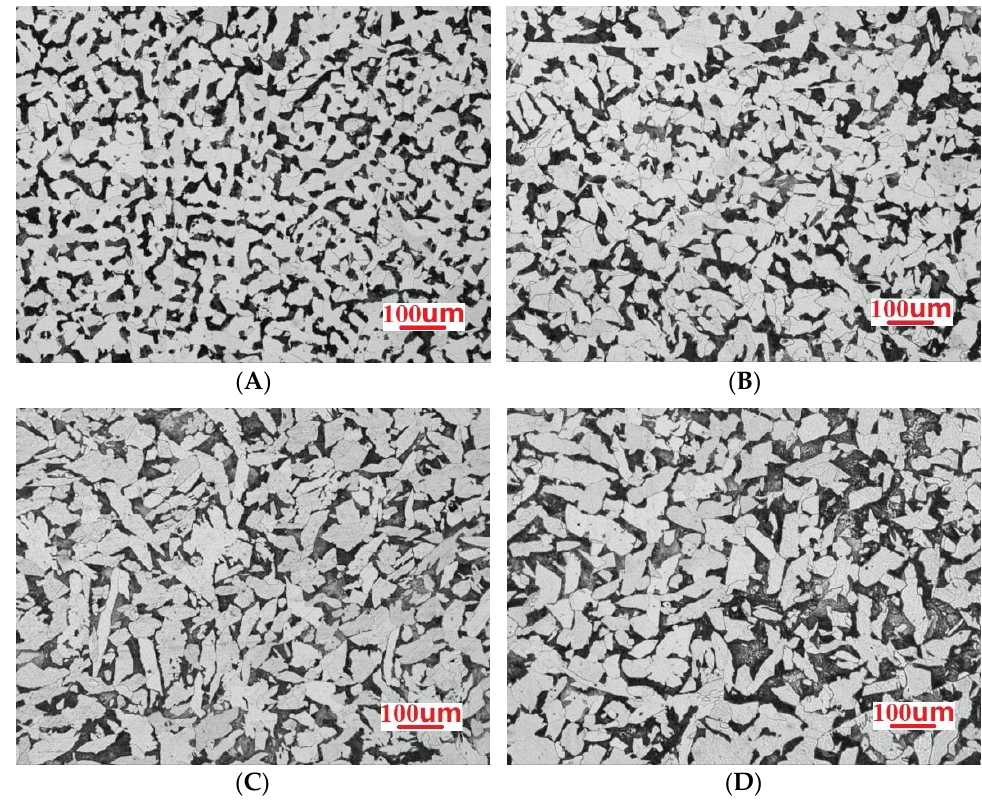
Figure 3. Microstructure of samples ( A – D ).